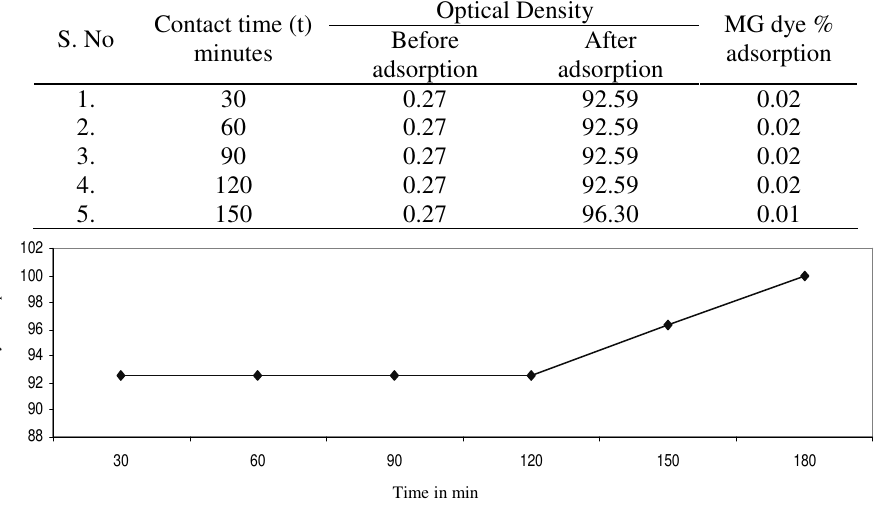
Figure 3 . Effect of contact time on removal of MG dye (15 mg/L)